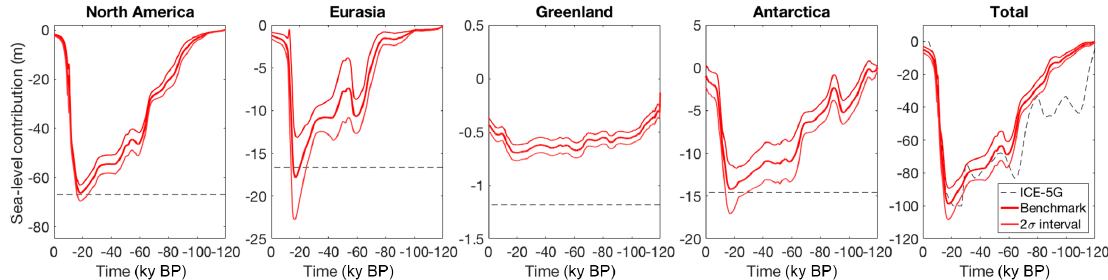
Figure 11. Modelled sea level contribution over time for all four individual ice sheets and the total sum. The ± 2 σ confidence interval is shown for the ensemble of simulations from the sensitivity